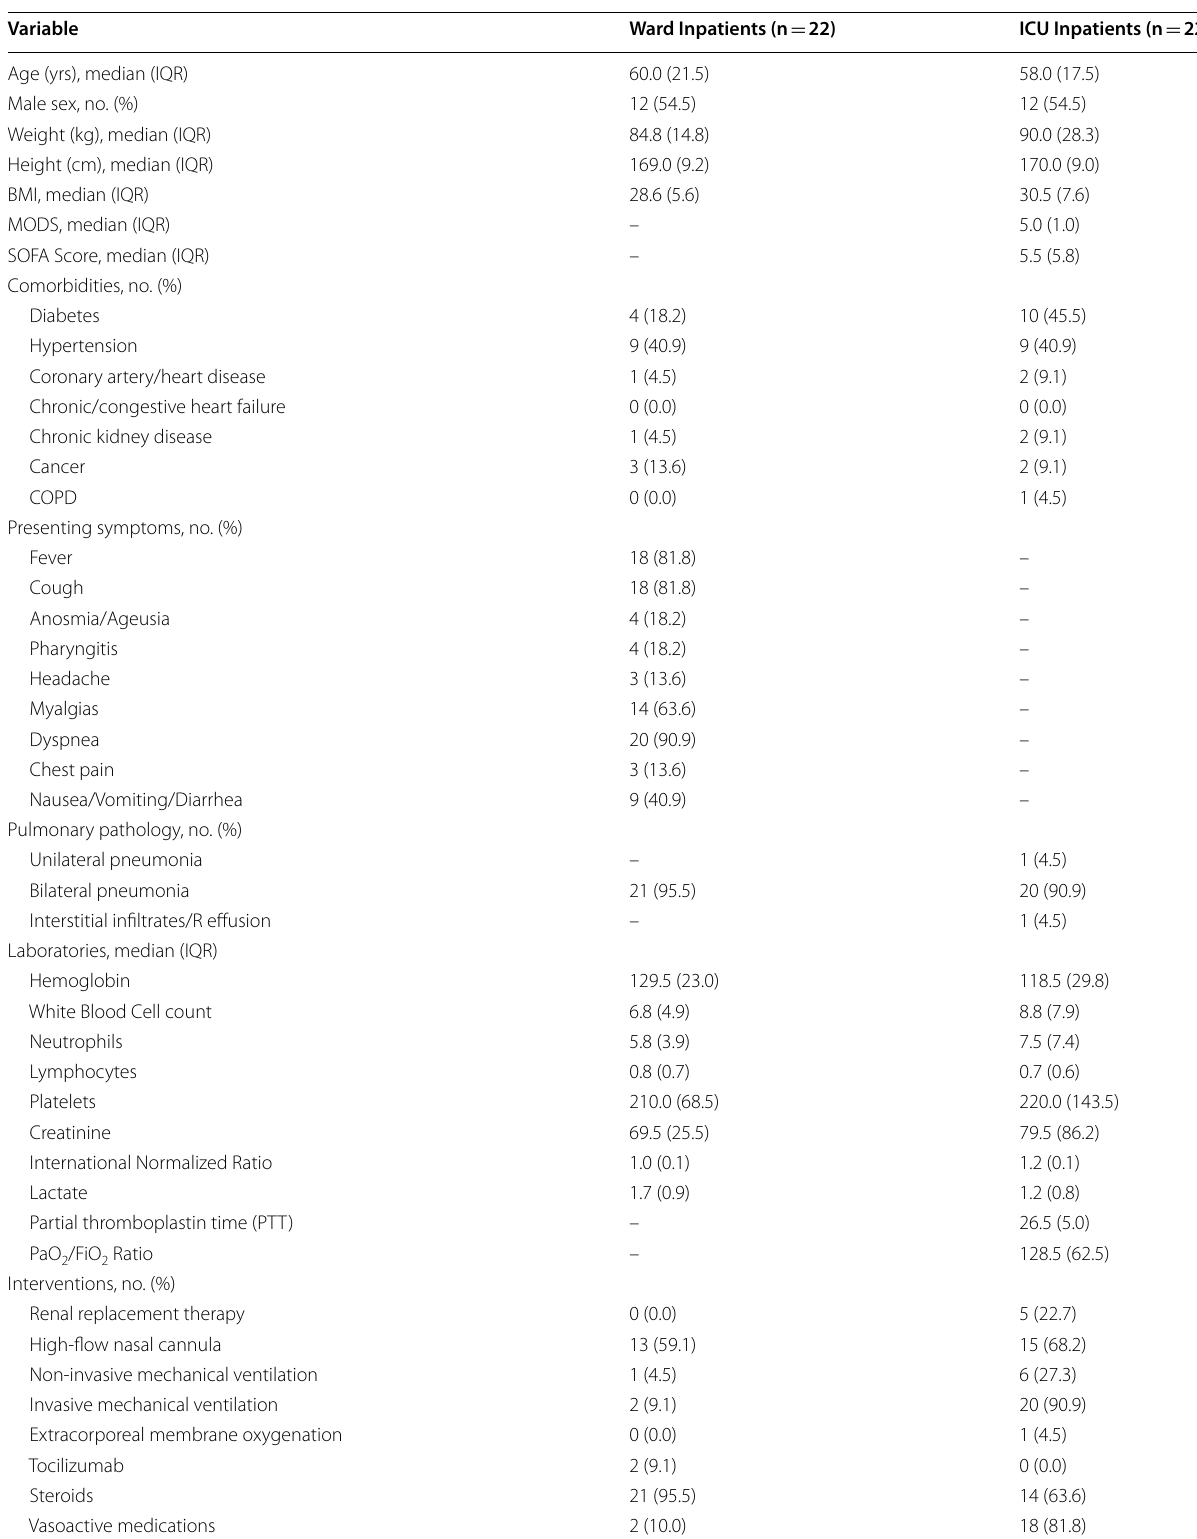
Table 2 Acutely ill COVID-19 inpatient demographics and clinical data